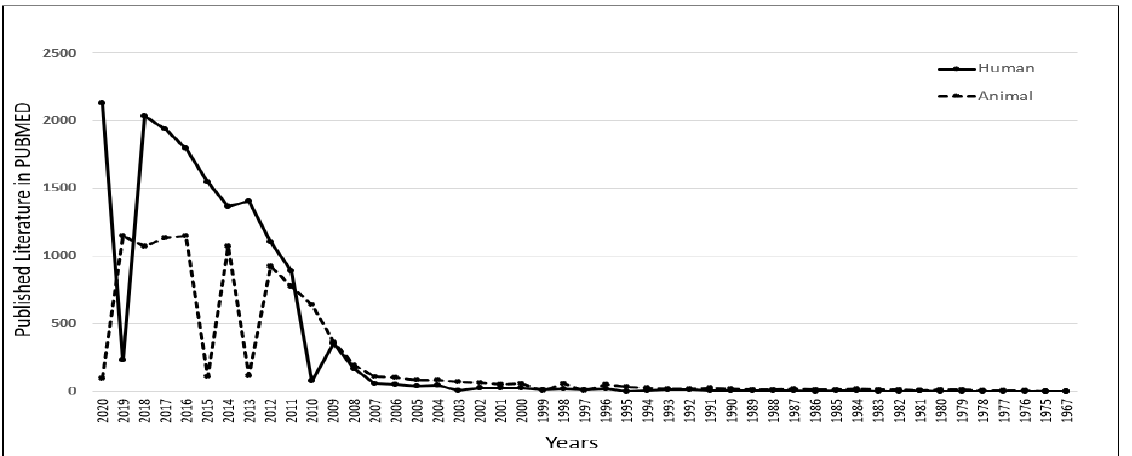
Figure 1. Understanding the role of induced pluripotent stem cells (iPSCs) in scientific research. Published data with the keyword iPSCs were compared in PUBMED for human versus animal. It was observed that there was an increase in human-related iPSCs research from 2011.